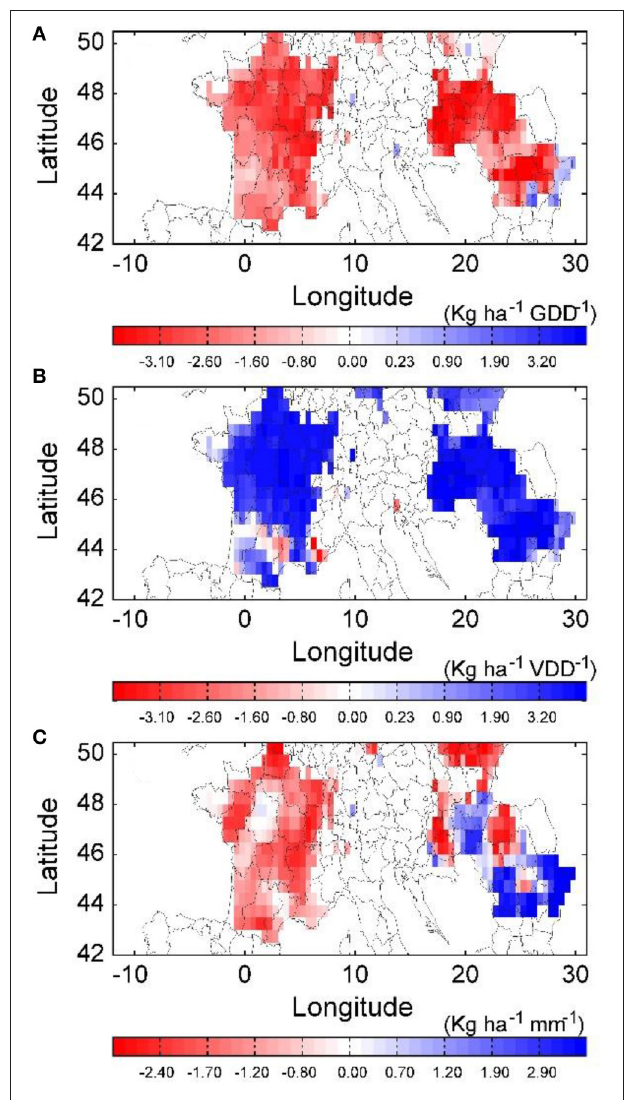
FIGURE 1 | Spatial patterns in the interannual sensitivity of winter wheat yields to climate variations over temperate Europe during 1975–2009. The interannual sensitivity of winter wheat yields to growing-season (from planting to harvest) growing degree days (GDD), vernalization degree days (VDD, based on the quadratic function in ORCHIDEE_crop model) during vernalization period (from planting to start of anthesis, in detail see Methods) and total growing-season precipitation for each grid is estimated by adjustable multivariate linear regressions and shown in (A–C) , respectively. White grids indicate that there are no/few yield statistic data available or there is no winter wheat planted. Regions shown in this figure are NUTS 2 regions for crop yield statistics (http://epp.eurostat.ec.europa.eu).